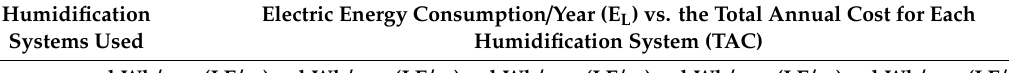
Table 3. Total annual cost and electric energy consumption for the three humidification systems in di ff erent